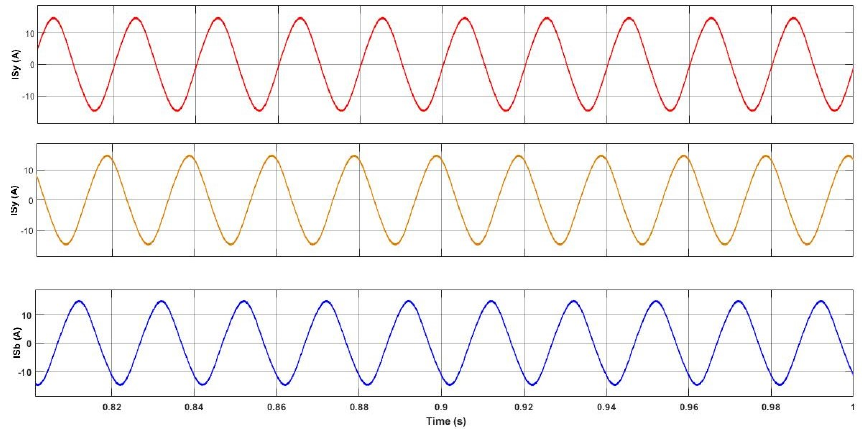
Figure 10. ILr: R-phase load current, ILy: Y-phase load current, and ILb: B-phase load current.